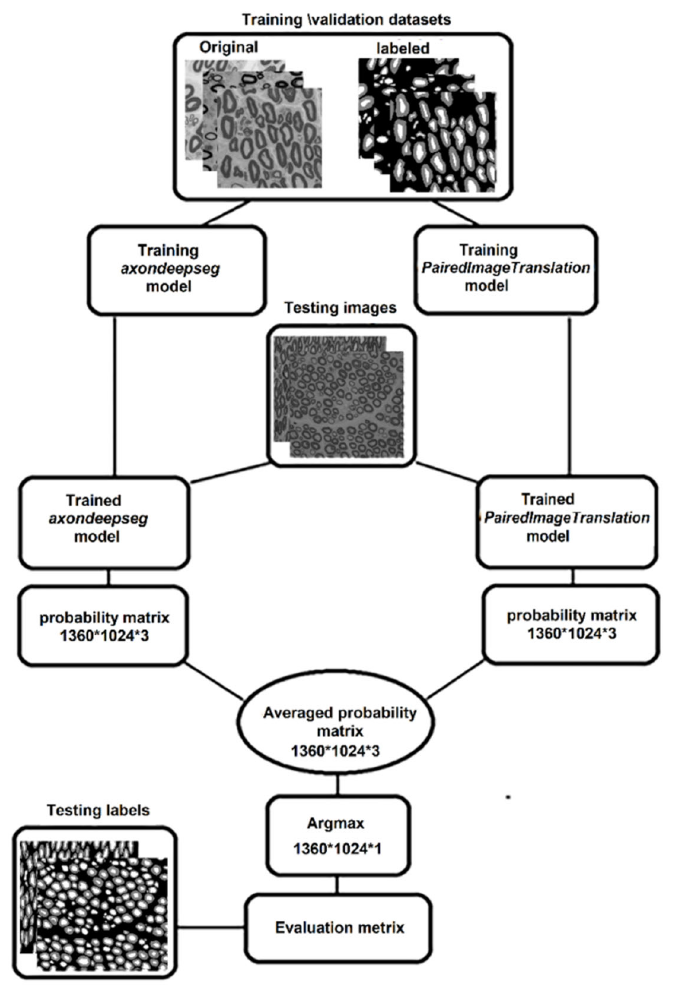
Figure 2. Overview of the ensemble algorithm pipeline. During the learning step, the training set is fed into both models. The test images are then fed into both models and the prediction matrices are collected following the Softmax function analysis. The probability matrices are then averaged pixel-wise and the argmax function is used for prediction. Finally, the evaluation metrics are used to assess the performance of the ensemble training model by comparing the ground truth test labels with the prediction